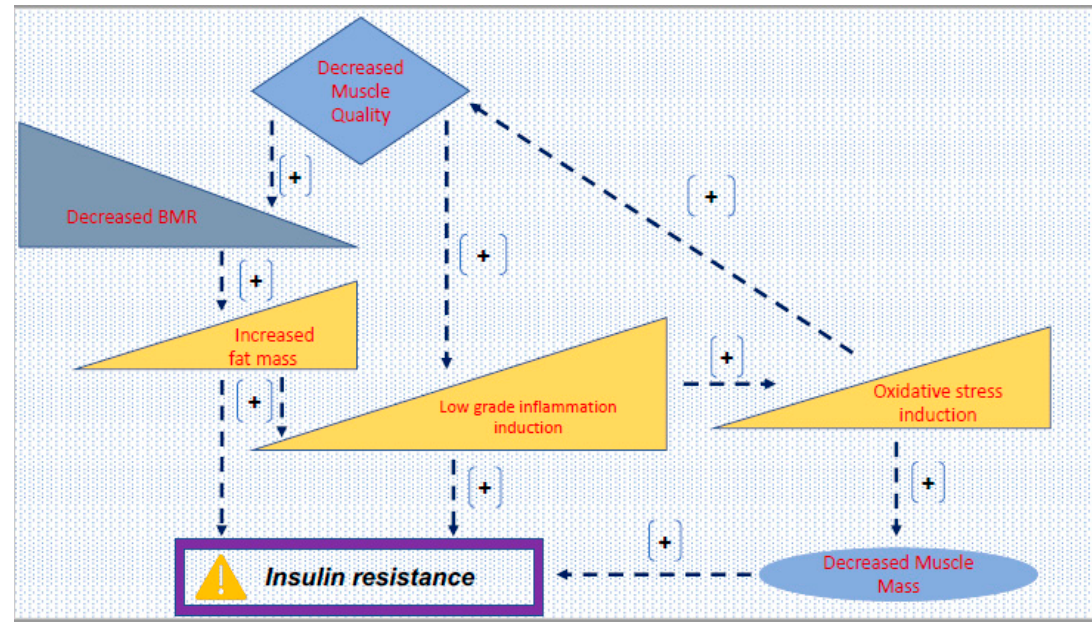
Figure 1. Potential pathways via which sarcopenia contributes to insulin resistance. [+] signs indicate an induction in the process (biochemical pathway), all eventually leading to stimulation of insulin resistance N.B.: Triangular shapes (ramps) graphically conceptually denote increase (left to right) or decrease (right to left) in the outcome specified within (basal metabolic rate (BMR)).